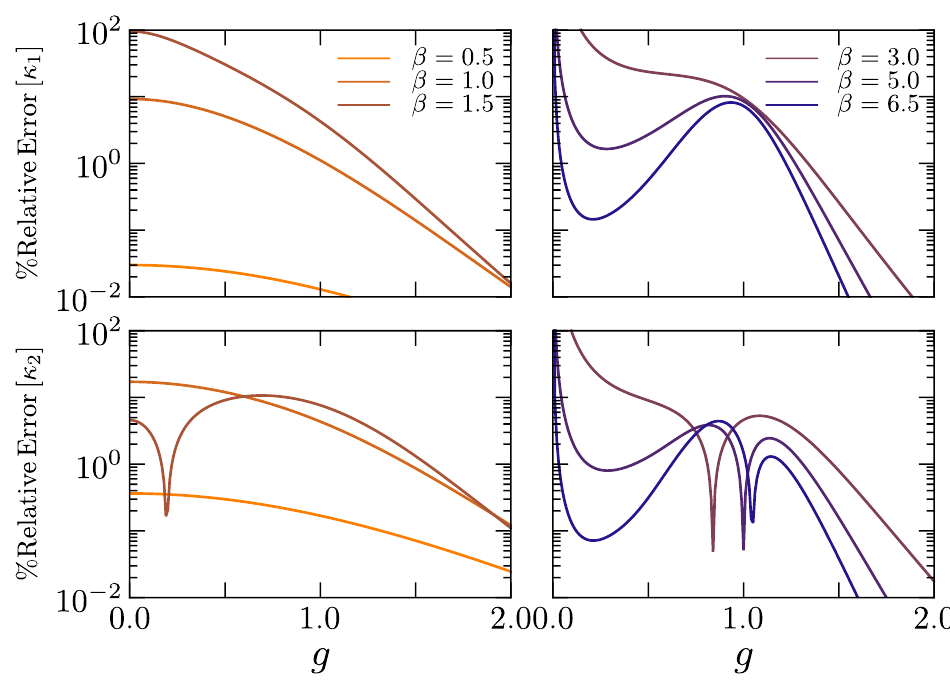
Figure 6: Relative error for the first two cumulants of the kink-number distri- bution as a function of magnetic field g . Using the full characteristic function in Eq. (85) and the PPA characteristic function Eq. (89), the relative error is evaluated as a function of the magnetic field for a system size L = 12 and different